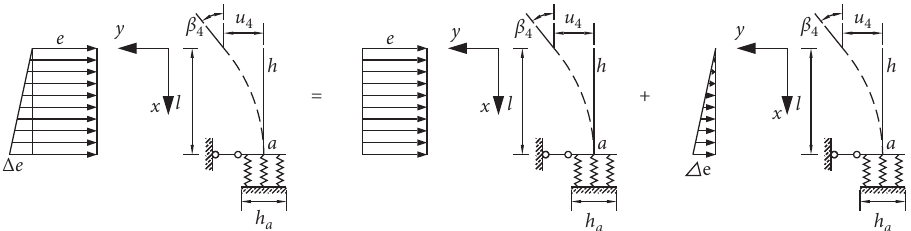
Figure 28: The displacement of the side wall under lateral trapezoidal